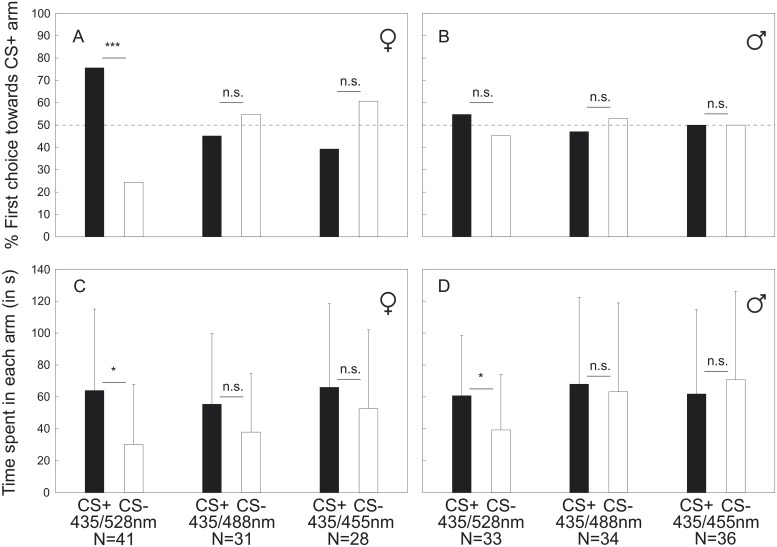
Information transfer after PER conditioning to Y-maze.Workers (A; C) and drones (B; D) were tested 2 h after end of conditioning for transfer of the learned color information to a novel operant context. Proportion of first choice of the bumblebees towards the CS+ arm (A: workers; B: drones) for three different color combinations (435/528 nm; 435/488 nm and 435/455 nm) and time (C: workers; D: drones) spent in each arm (in seconds). Since there were no significant differences within the respective color combination regarding the rewarded stimulus during the first choice towards the CS+ arm and time spent in each arm, all data were pooled for each tested color combination. *** P < 0.001; * P < 0.05; n.s.: not significant.